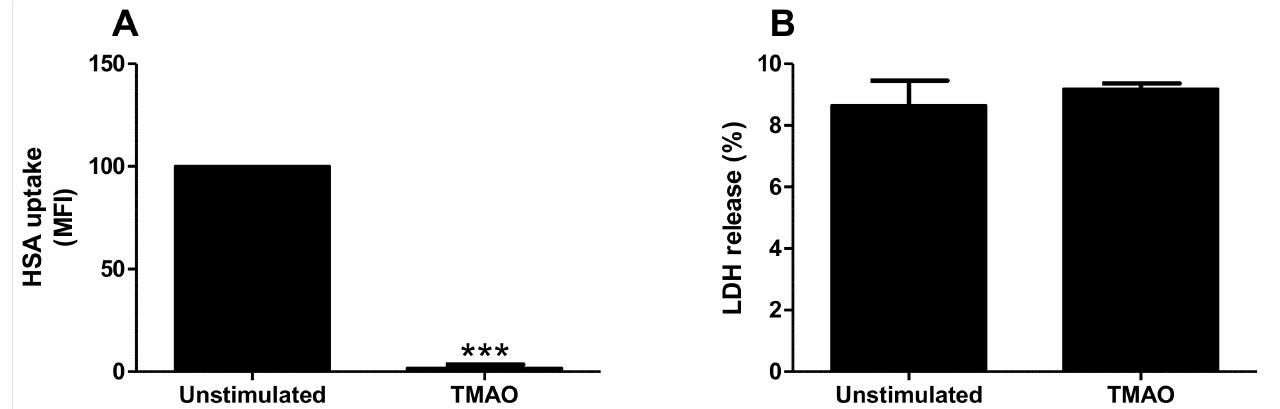
Figure 4. TMAO reduced albumin uptake in proximal tubular cells. HK-2 cells were stimulated with TMAO (300 µ M) for 24 h ( A , B ) and HSA uptake ( A ) and LDH release ( B ) were evaluated. Data are presented as mean ± SEM (n = 3–6 independent experiments). HSA, human serum albumin. MFI, mean fluorescence intensity. Asterisks denote statistical significance compared to unstimulated cells (*** p <